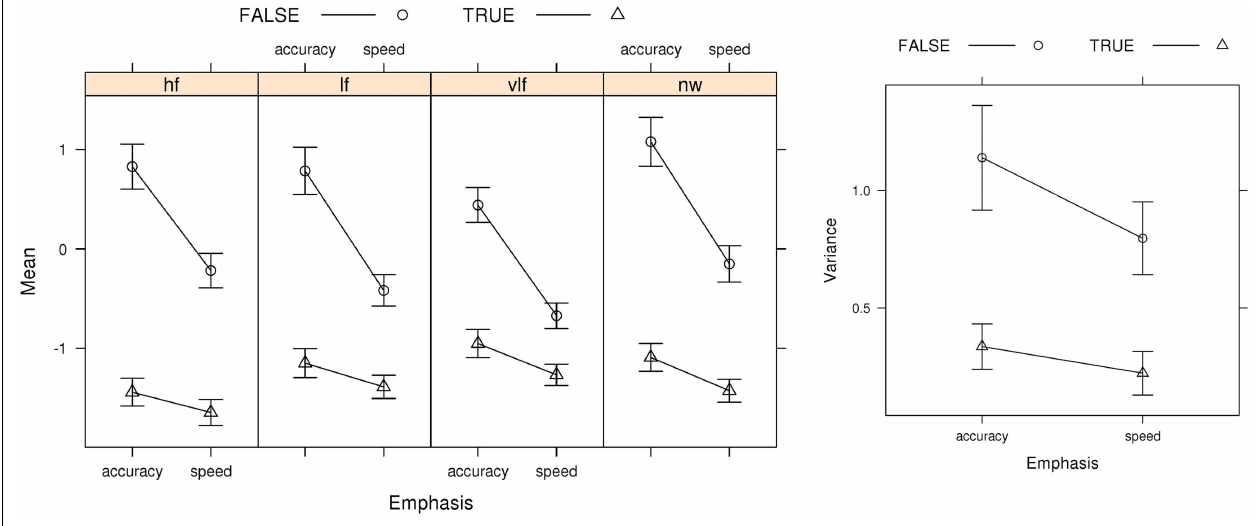
FIGURE 6 | Best LNR ( µ ∼ E ∗ W ∗ C & σ 2 ∼ E ∗ C & t 0 ∼ E ) µ (Mean), and σ 2 (Variance) parameter estimates averaged over participants, with bias-corrected within-subject 95% confidence intervals (Morey, 2008).